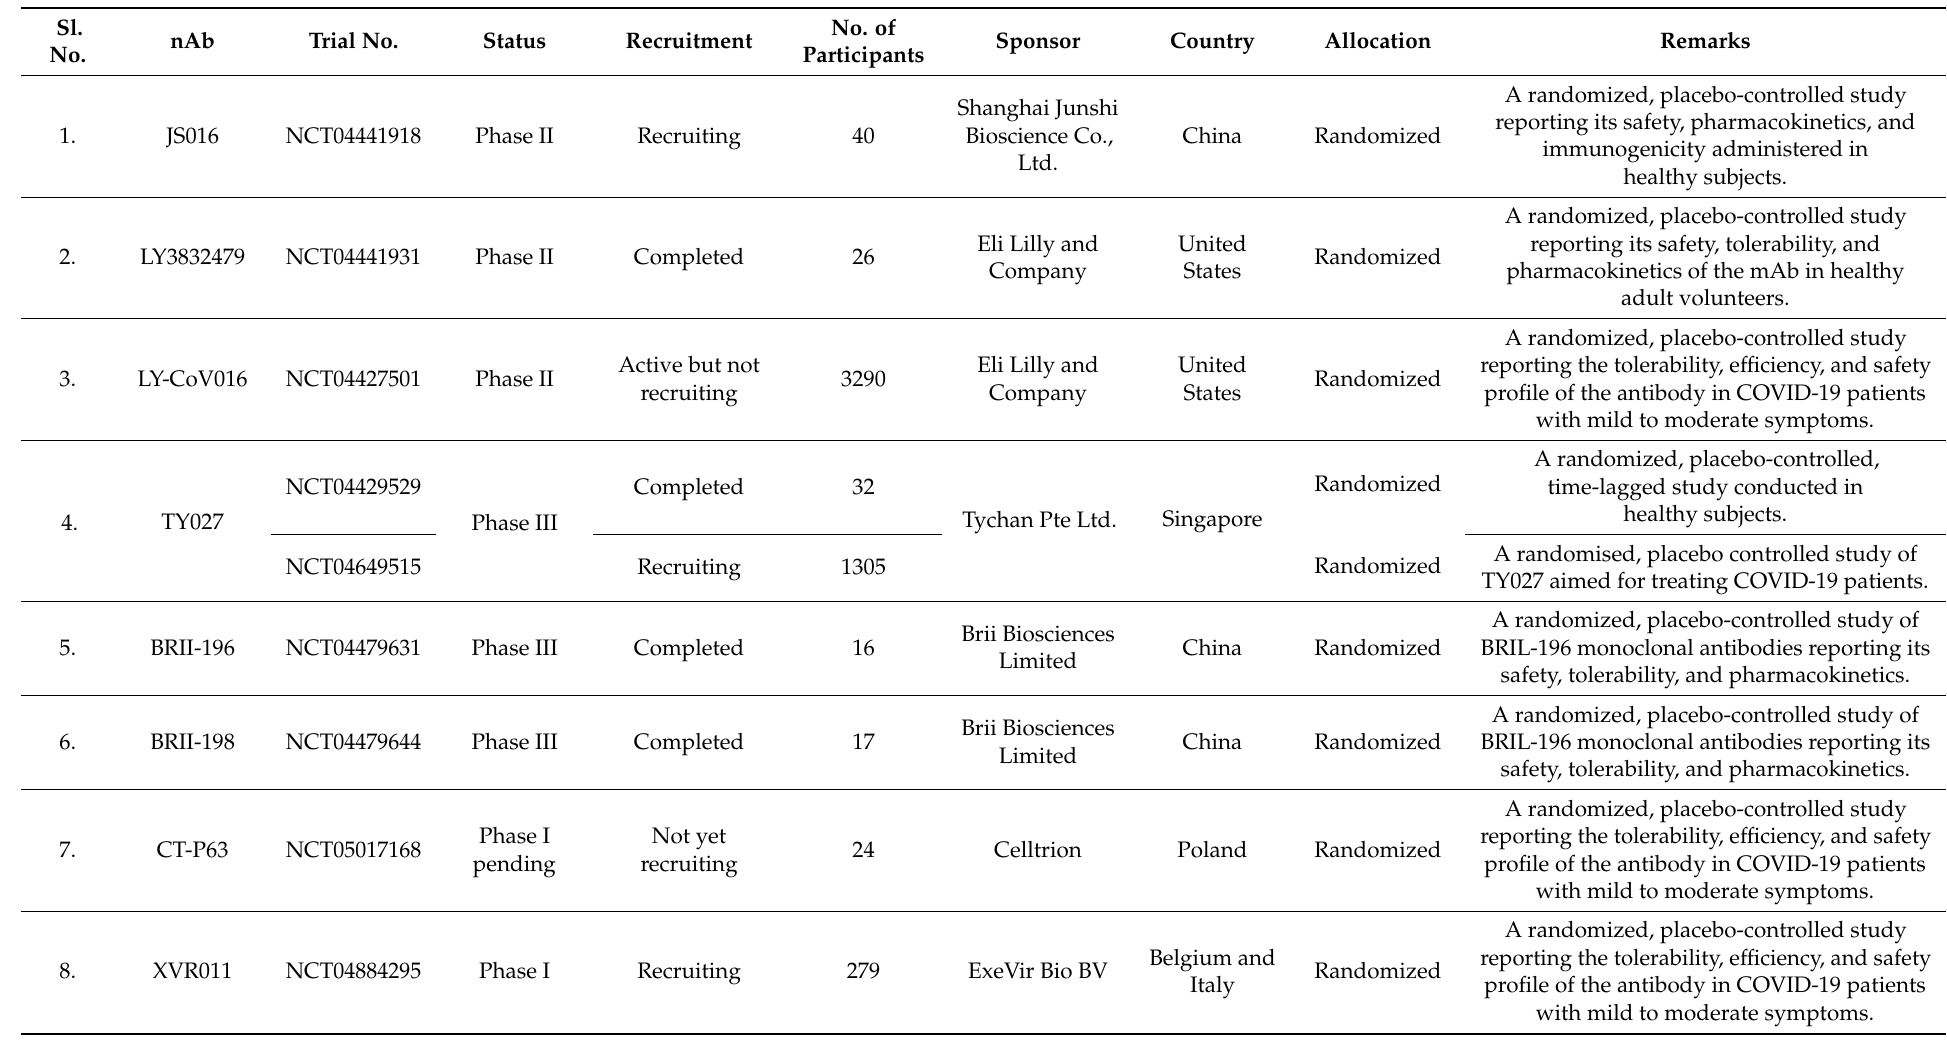
Table 2. Different neutralizing antibodies which are in clinical